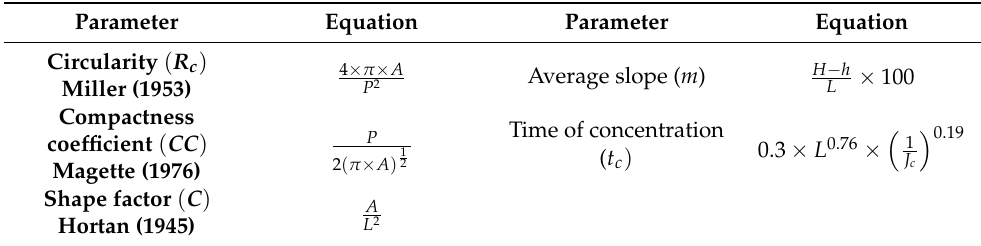
Table 2. Equations related to the watershed morphometric parameters. Parameter Equation Parameter